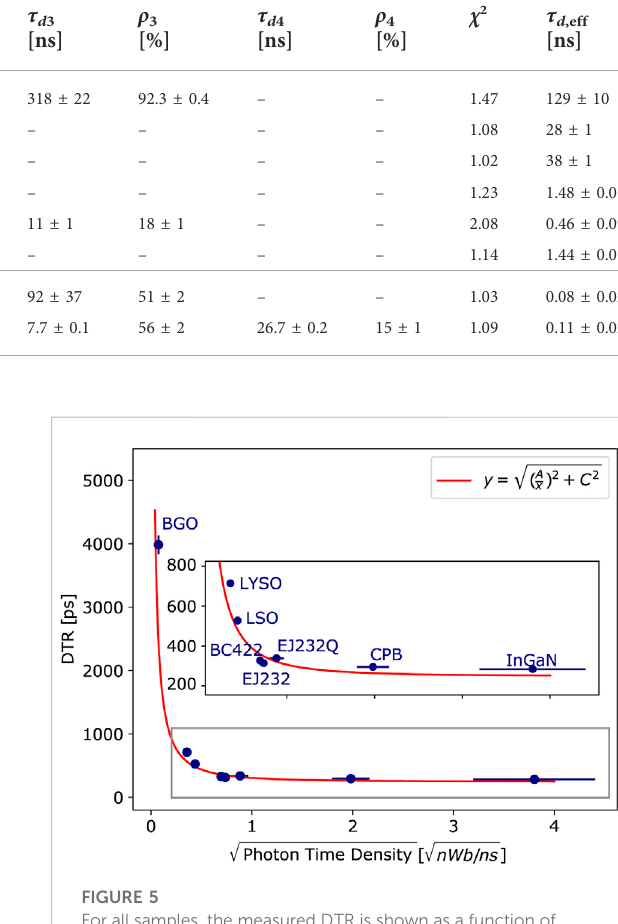
FIGURE 4 Time delay distribution of all the measured standard scintillator.